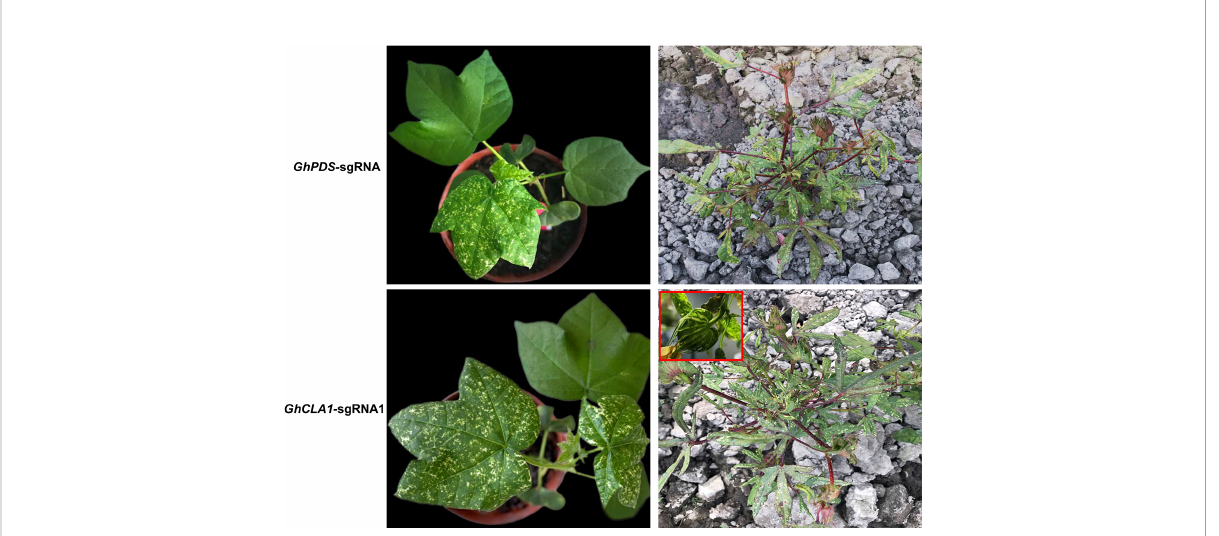
FIGURE 7 Mutation phenotypes of GhPDS and GhCLA1 genes in cotton. In the fi eld, the incomplete albino phenotype of these two genes persisted into the reproductive growth stage. The red box shows the cotton boll albinism mutant